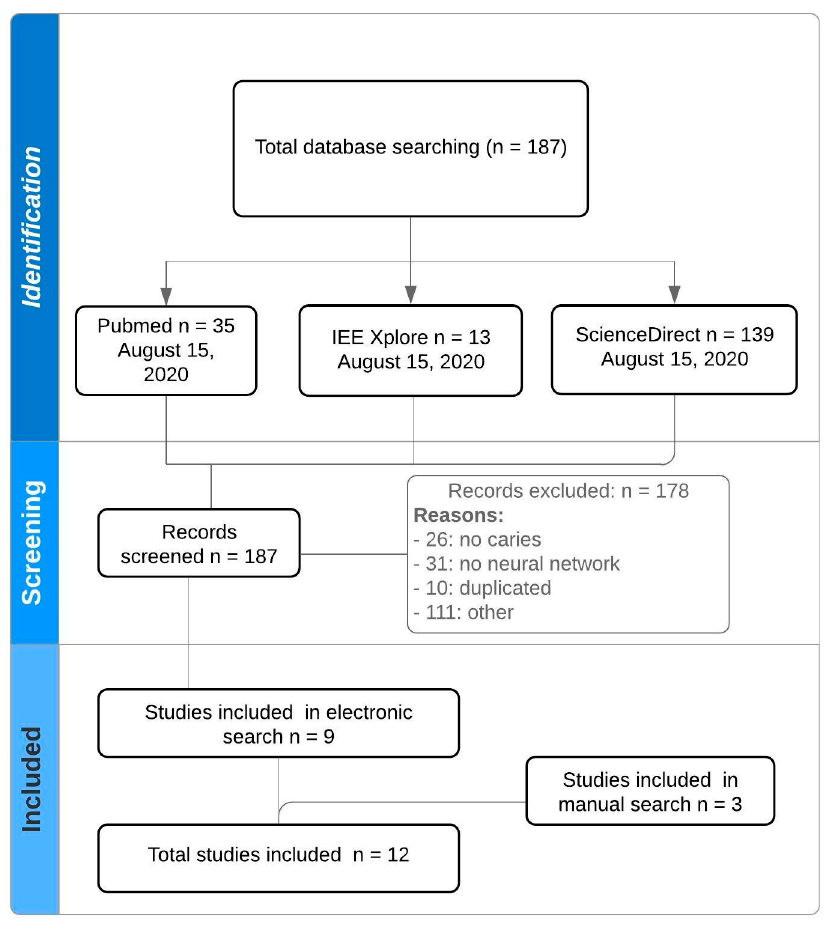
Figure 1. Flowchart Figure 1.